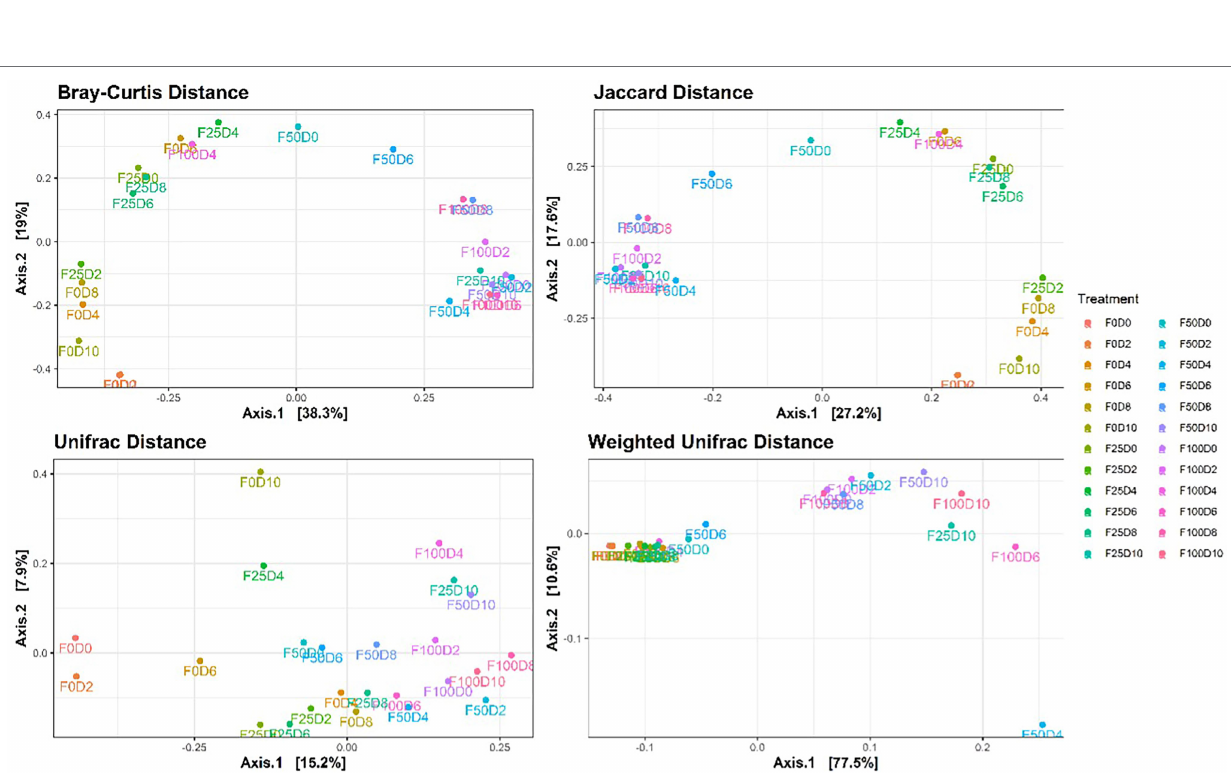
FIGURE 4 | Principal coordinate analysis (PCoA) based on Bray–Curtis, Jaccard, UniFrac and Weighted UniFrac metric distances for the 24 treatments.